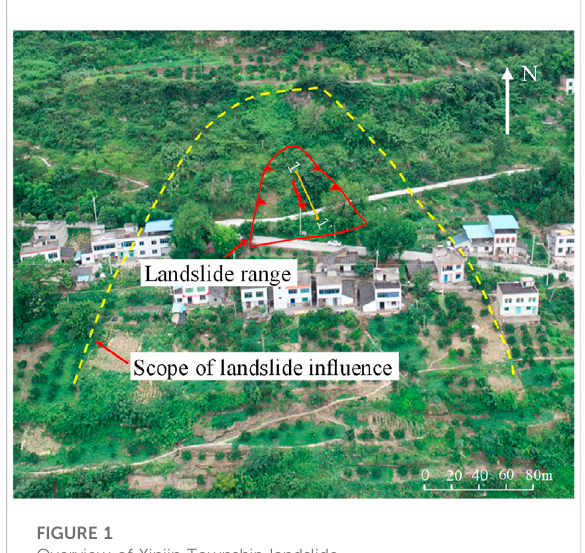
Overview of Xinjin Township